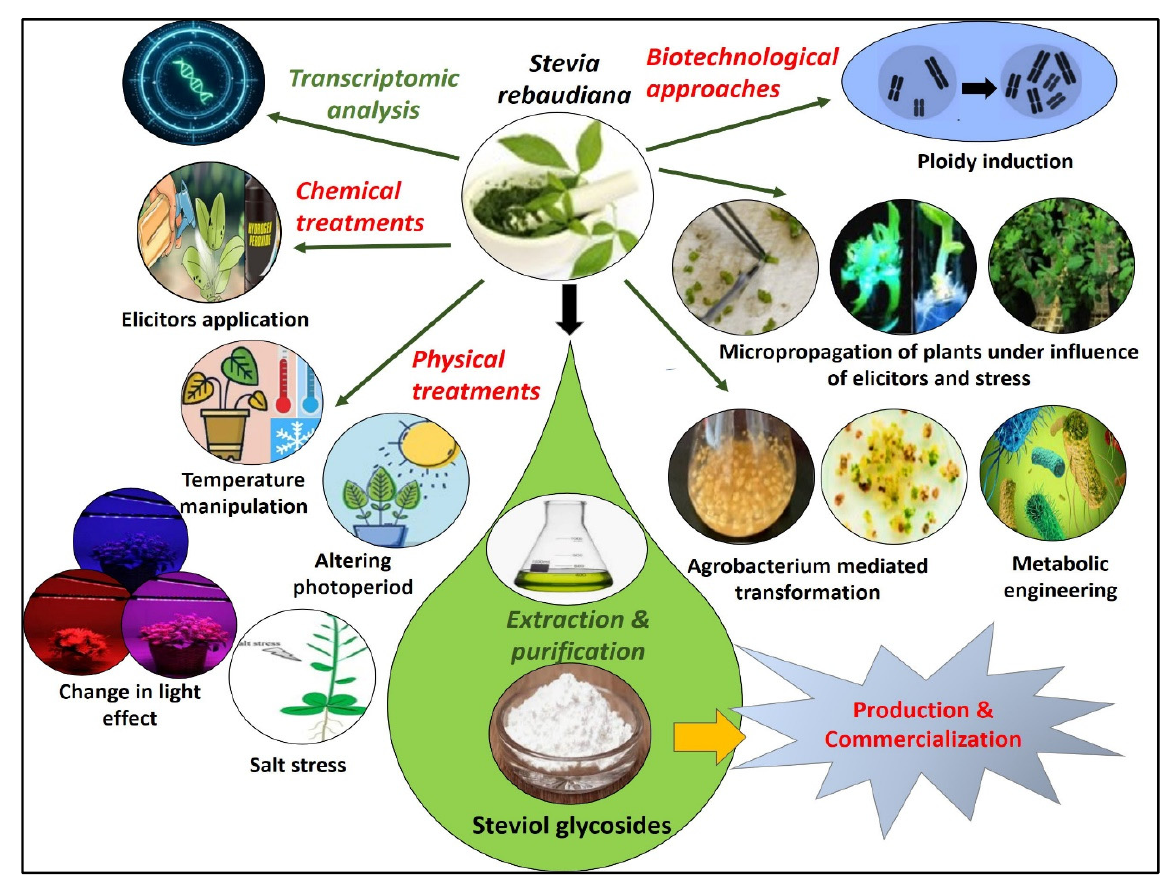
Figure 3. Pictorial representation of the various approaches employed to increase steviol glycosides synthesis. Libik et al. [21]; Zhao et al. [113]; Cox et al. [114]. synthesis. Libik et al. [21]; Zhao et al. [113]; Cox et al.